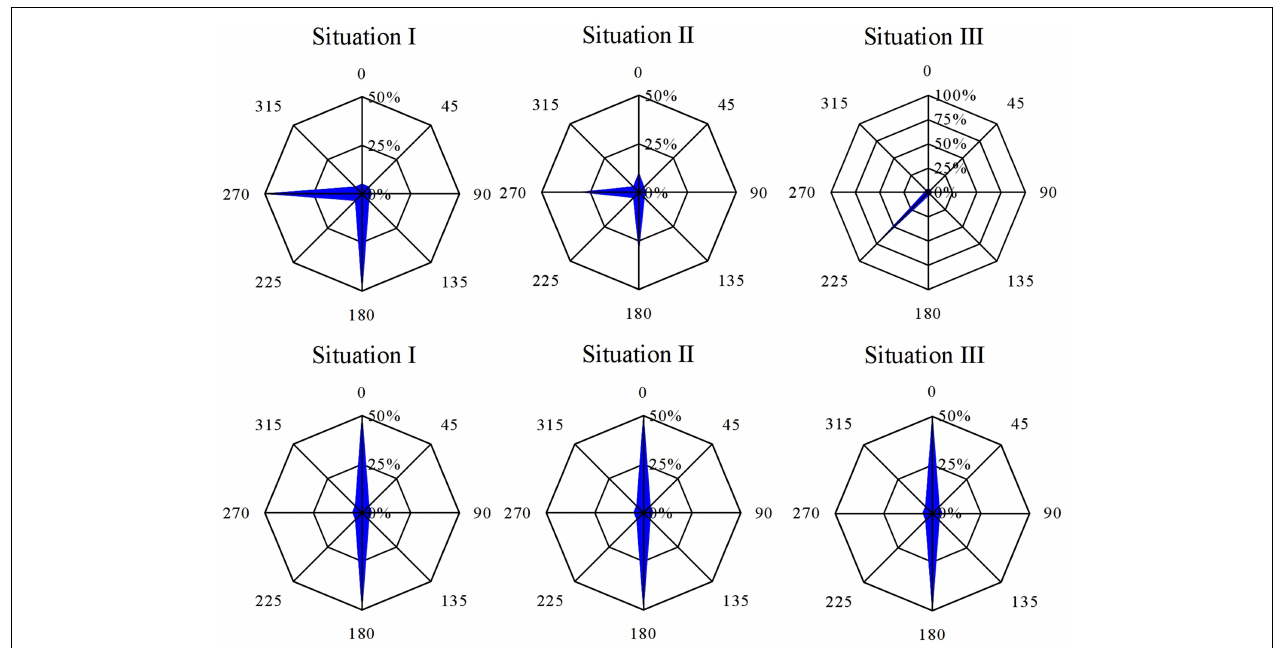
FIGURE 6 | Resultant angular distribution for each of the different polarization scenarios considered. Note that 180 ◦ reorientation yields for each of these situations a diametrically bimodal distribution (see text for explanation).